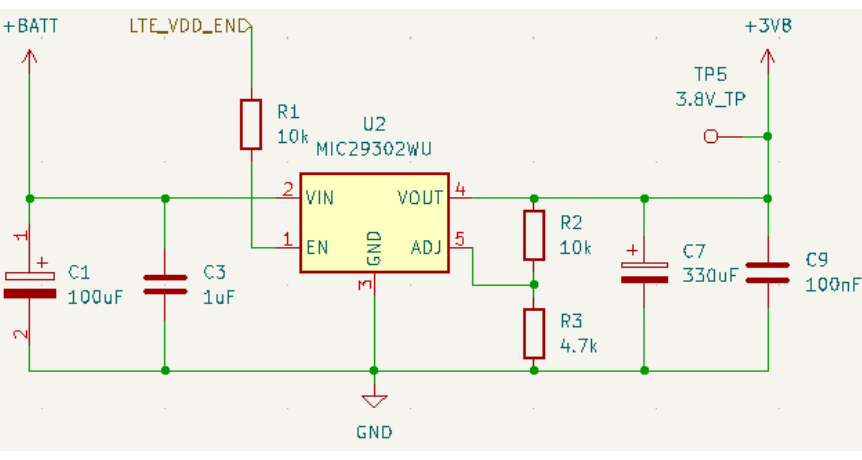
Figure 5. Schematic of the 3.8 V regulator. The NCP1117LP LDO regulator is capable of providing 1 A output current with a dropout voltage of 1.3 V at full current load. The NPC1117 “family” has adjustable and fixed voltage members. On the plug-in board, we used the fixed 3.3 V version. As with the MIC regulator, it also has internal protection features. This regulator feeds more com- ponents on the plug-in board, including the RTC. Therefore, it is constantly turned on. 2.5. On/off Timing Circuit Raspberry Pi single-board computers have no sleep mode. Therefore, an external cir- cuit is necessary in those applications where on/off scheduling is required. Commercial HATs (Hardware Attached on Top) exist for this task, such as the Sleepy Pi, WittyPi, and PiJuice [19]. These HATs can stabilize the DC power supply from a fluctuating DC power source. Moreover, some of them are also capable of programmatically turning the Rasp- berry Pi on and off. However, all of those HATs apply an additional independent micro- controller to the Raspberry Pi’s safe shutdown. In addition, some circuits cannot be effi- ciently integrated into special-purpose circuits. Therefore, in this section, we propose a special solution to on/off scheduling. An RTC circuit is needed to time the Raspberry Pi startup. We used the MCP79410 real-time clock and calendar from Microchip (Figure 6). Its operating voltage range is be- tween 1.8 V and 3.3 V, and it requires a very low (1.2 uA) timekeeping current. In the circuit, the RTC operates continuously on the independent 3.3 V power line; therefore, it does not need to be reset every time the system is restarted. The clock source of the RTC is a 32.768 kHz external crystal. The Raspberry Pi communicates with the MCP79410 via the I2C interface. Both lines of the interface are open-drain; therefore, both of them require a pull-up resistor. Beyond the power, clock, and communication lines, the MCP79410 has one additional important pin. This is the MFP (Multi-Function Pin), which can be used as an alarm output. The alarm functionality of the RTC is very simple. If the counter reaches a pre-defined time point, the voltage level of the MFP will be changed (both positive and negative logics are supported). This output signal is used to turn the 5 V LDO voltage regulator on/off, but not directly.